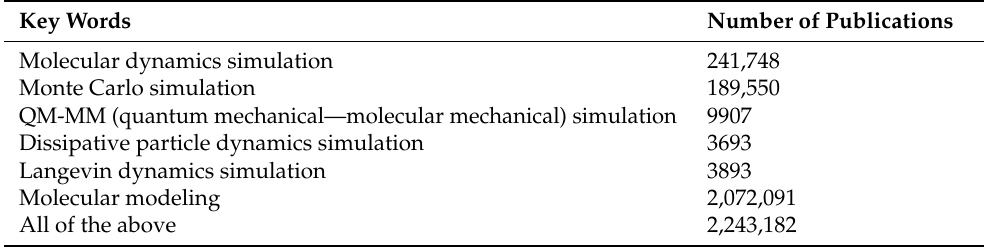
Table 1. Number of publications from Web of Science search on 8 September